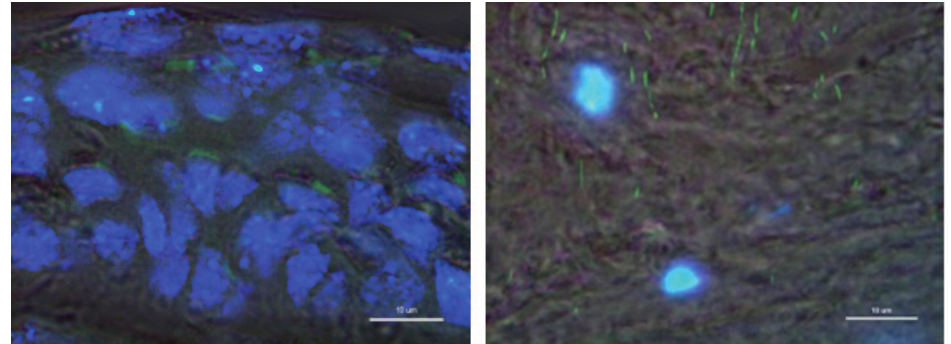
Figure 6. The histological analysis of cyclo -( D -Trp-Tyr) peptide nanotubes’ (PNTs) distribution in tissues of nude mice after 180 min of eye drop delivery with thioflavin T (ThT) pre-stained PNTs. The ThT image (green) is merged with DAPI nuclear staining (blue) and the bright field image. Note that the ThT pre-stained PNTs (green color) were located in both the epithelial (left) and stroma area (right). Scale bars denote 10 μ